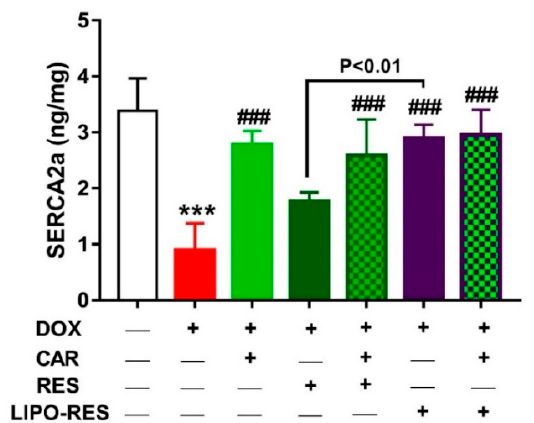
Figure 8. CAR and / or RES and LIPO-RES increase cardiac SERCA2a in DOX-intoxicated rats. Data are expressed as mean ± SEM, ( n = 6). *** p < 0.001 versus Control. ### p < 0.001 versus DOX.